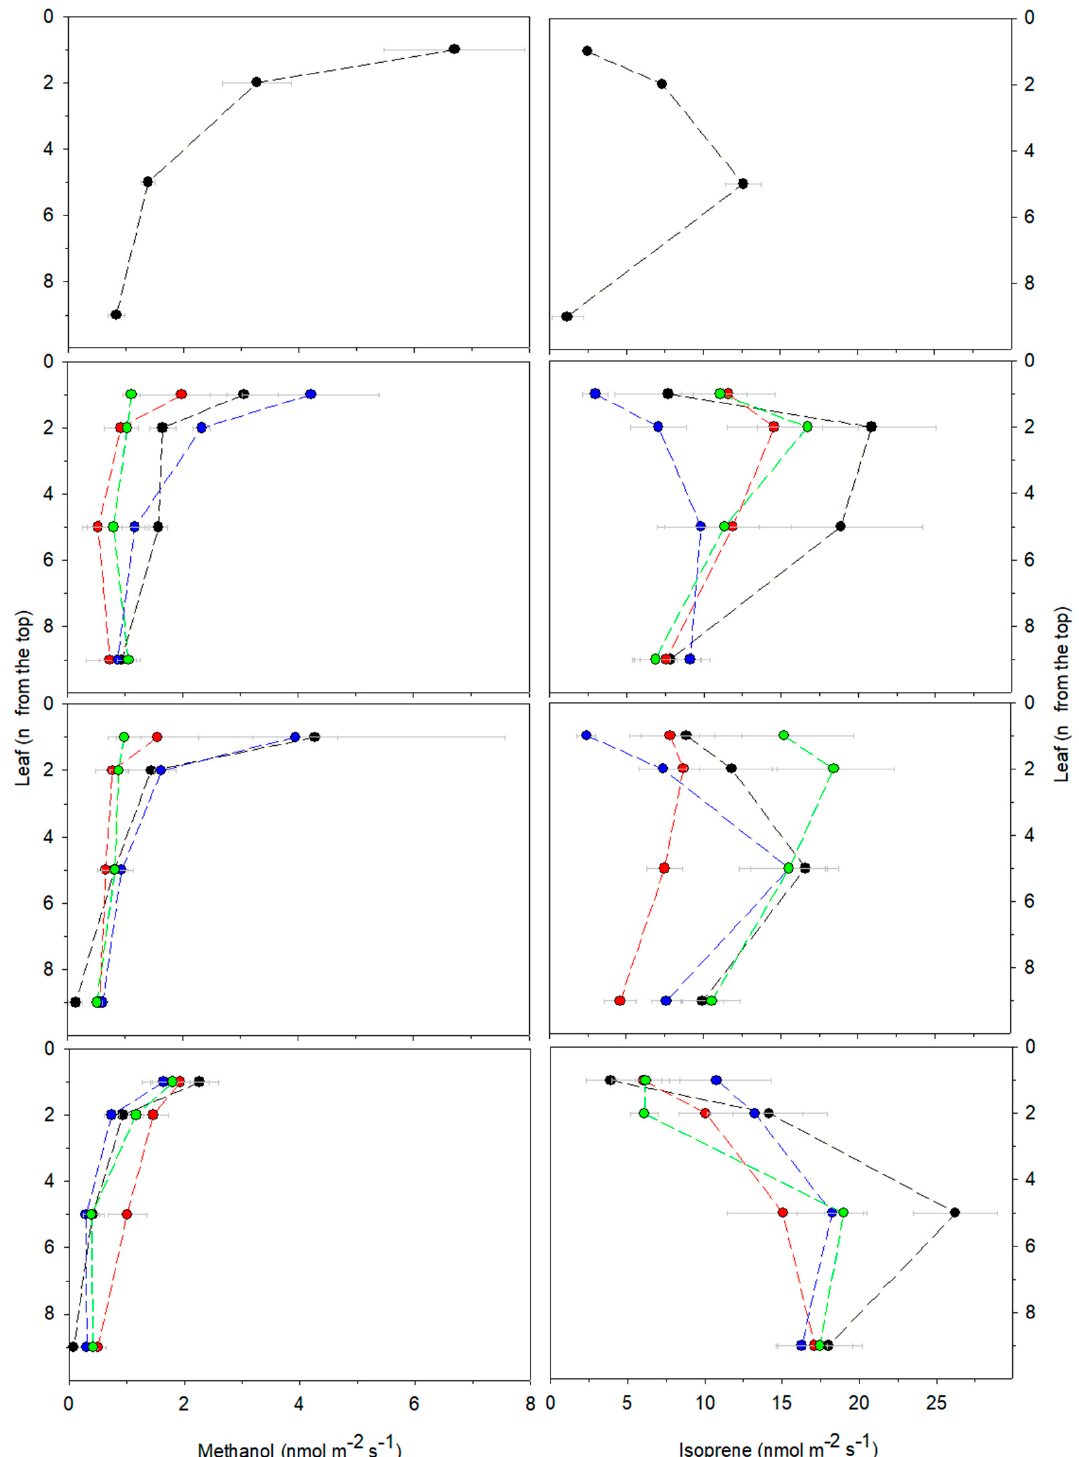
Figure 3. Emission of methanol and isoprene measured at different time points (T0, T1, T2, and R) from the 1st and 2nd (apical), 5th (median), and 9th (basal) leaves counted from the top of Arundo donax controls (black circles), salt-stressed (red circles), ALA-treated (blue circles), and both salt- stressed and ALA-treated (green circles) plants. Dotted lines connect leaves belonging to the same plant profile. Mean values ± SE are shown. Statistically significant difference between (apical, median, and basal) leaves of plants undergoing the same treatment and between (apical, median, and basal) of plants undergoing different treatments are shown in Table